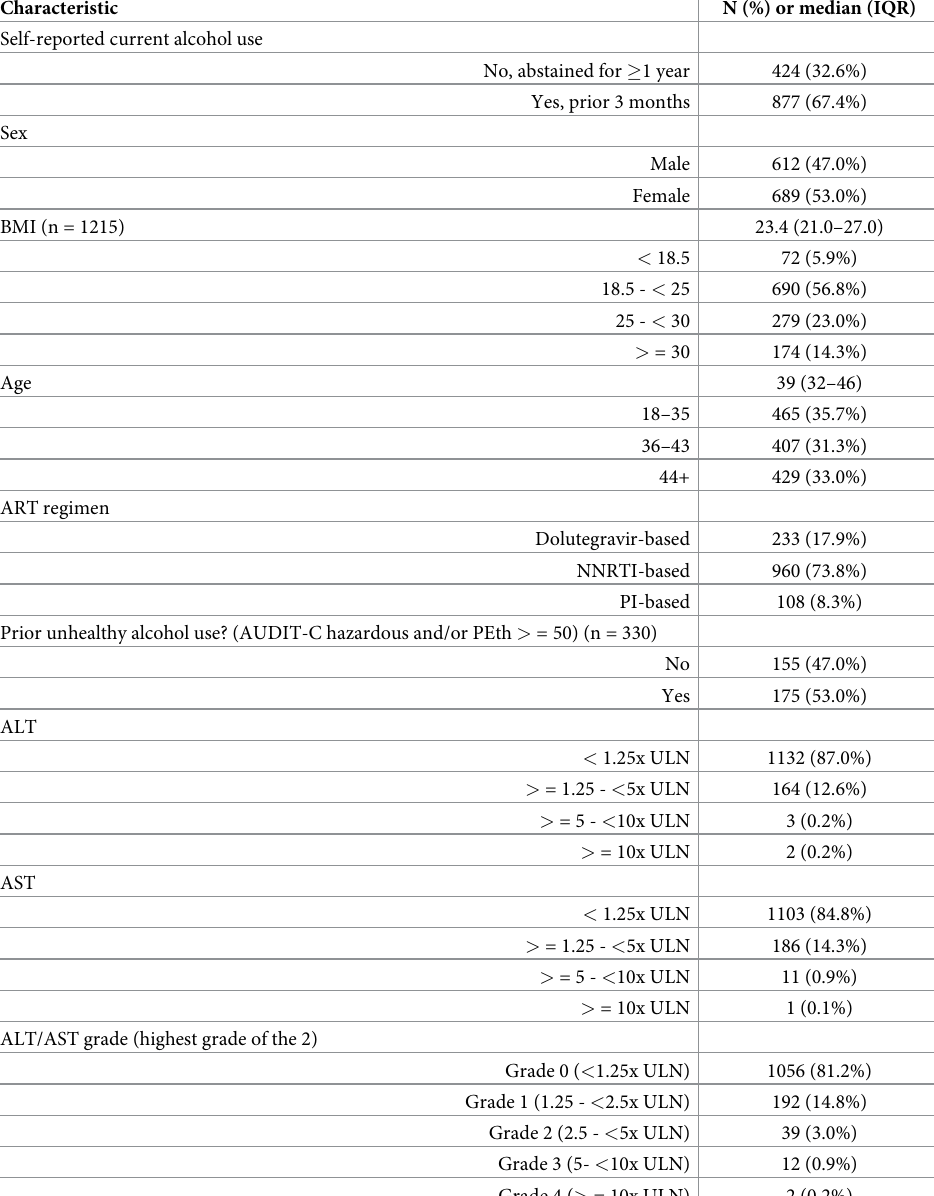
Table 1. Participant characteristics of those screened for the ADEPTT Study, with transminase results at screen- ing (n = 1301).